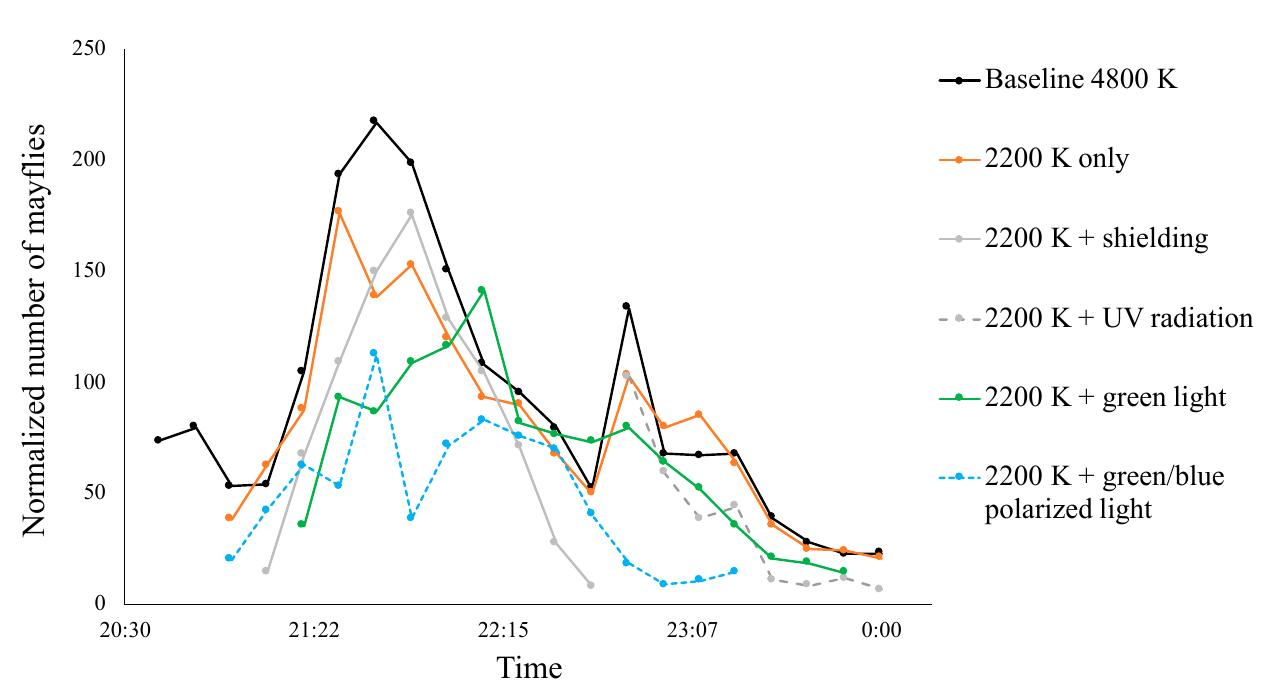
Figure 5. The normalized number of mayflies attracted to the bridge under each test scenario: baseline reference condition of 4800 K light at Span 12 (black continuous line), 2200 K test condition at Spans 20 and 28 in trials CW 1, 2, 4, 5, and 6 (orange continuous line), 2200 K combined with shielding at Spans 20 and 28 in trial CW3 (grey continuous line), 2200 K on the bridge and UV radiation under the bridge at Span 28 in trial CW2 (grey dashed line), 2200 K on the bridge and green light under the bridge at Span 28 in trial CW4 (green continuous line), and 2200 K on the bridge and green-blue polarized light combination under the bridge at Span 28 in trial CW5 (blue dotted line).